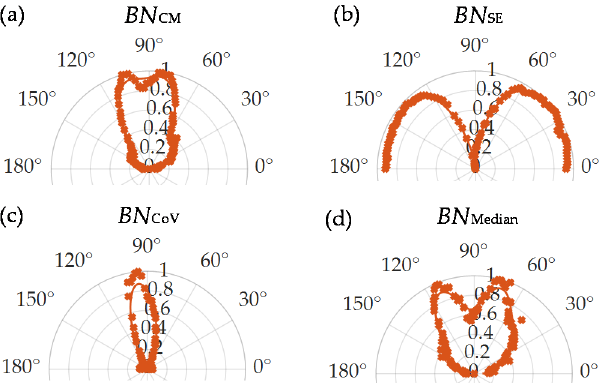
Figure 4. Polar charts (normalized to (0–1) range) of four exemplary time-frequency features extracted from MBN TF spectrograms obtained for selected sample C 27LS#1 : ( a ) BN CM , ( b ) BN SE , ( c ) BN CoV , ( d ) BN Median .